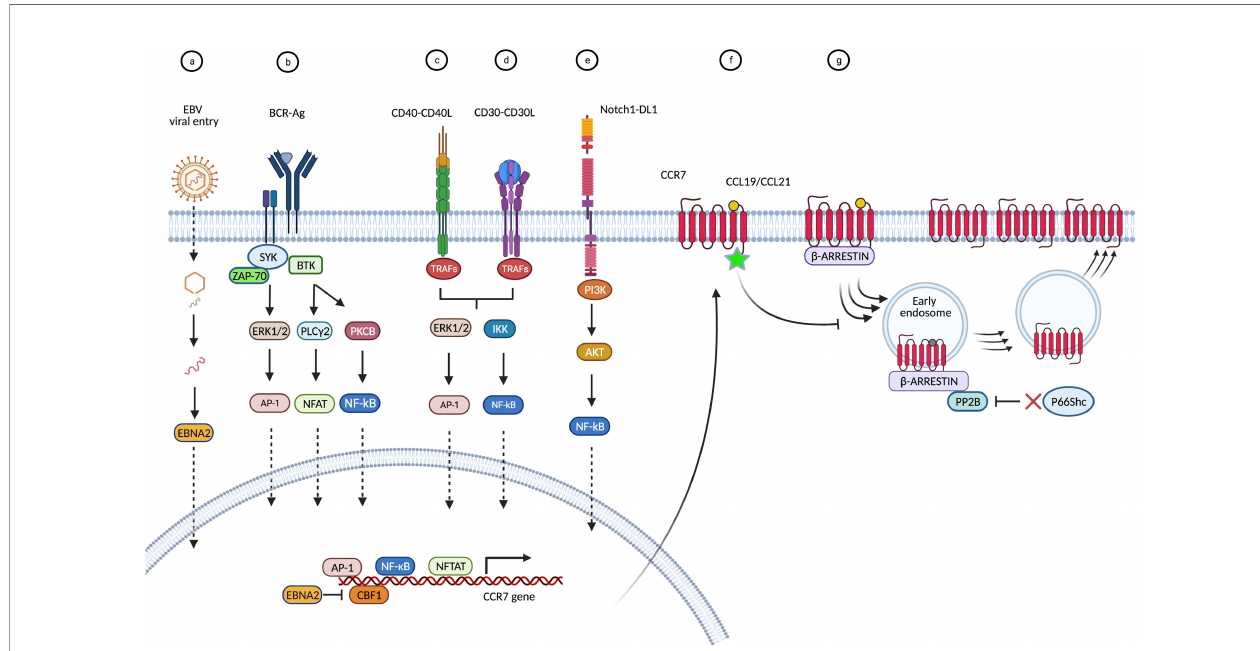
FIGURE 1 | Causes and modes that underlie CCR7 overexpression in blood cancers. Overview of proposed signaling cascades with reported data. (A) CCR7 upregulation may be promoted by EBV. In BL and DLBCL cells, following viral endocytosis, the virion and packaged proteins are released into the cytoplasm. The viral transactivator EBNA-2 binds to and inhibits the CCR7 gene repressor factor CBF-1 (also known as RBP-J k ) thus promoting CCR7 gene transcription (4, 89, 91). (B) In B-cell malignancies (CLL, B-ALL) tonic signaling through the BCR activates transcription factors such as NFATC1, NF- k B, and AP-1, which target the CCR7 gene (42, 54, 56). (C) When engaged by CD40L, the receptor CD40 recruits tumor necrosis factor receptor-associated proteins (TRAF) to the membrane, which initiate different signaling pathways leading to activation of NF k B or AP-1 (22, 23, 208, 209). (D) In cHL and ALCL, binding of CD30L (CD153) or sCD30 to CD30 can result in trimerization and signal mediation through TRAF proteins to stimulate the NF k B pathway resulting in CCR7 gene expression (3, 210). In addition, CD30 can signal through MAPK pathways, including ERK1/2 and the nuclear transcription factor AP-1, all leading to enhanced CCR7 transcription (3, 115, 117). (E) In T-ALL cells, release of intracellular Notch1 (ICN1) from membrane-tethered heterodimeric Notch1 protein upregulates PI3K/mTORC2/NF- k B pathways and activation of the CCR7 gene (25, 133). In CLL cells, activating mutations in Notch1 intracellular domain favor the downmodulation of DUSP22 phosphatase thus facilitating the accumulation of activated STAT3 which mediates CCR7 gene transcription (51). (F) Mutations in the C-terminal amino acid Trp355, located in the cytoplasmic region of CCR7, impair internalization upon ligand stimulation resulting in increased expression of the surface receptor in ATLL cells (162, 163). (G) Dysregulation of the endocytic machinery of CCR7, e.g. in CLL, impacts receptor turn-over and increases CCR7 membrane expression. De fi ciency of the cytoplasmic p66Shc protein causes enhanced activity of the PP2B/calcineurin phosphatase on the endosomal CCR7 pool, which enhances its recycling back to the plasma membrane (43,